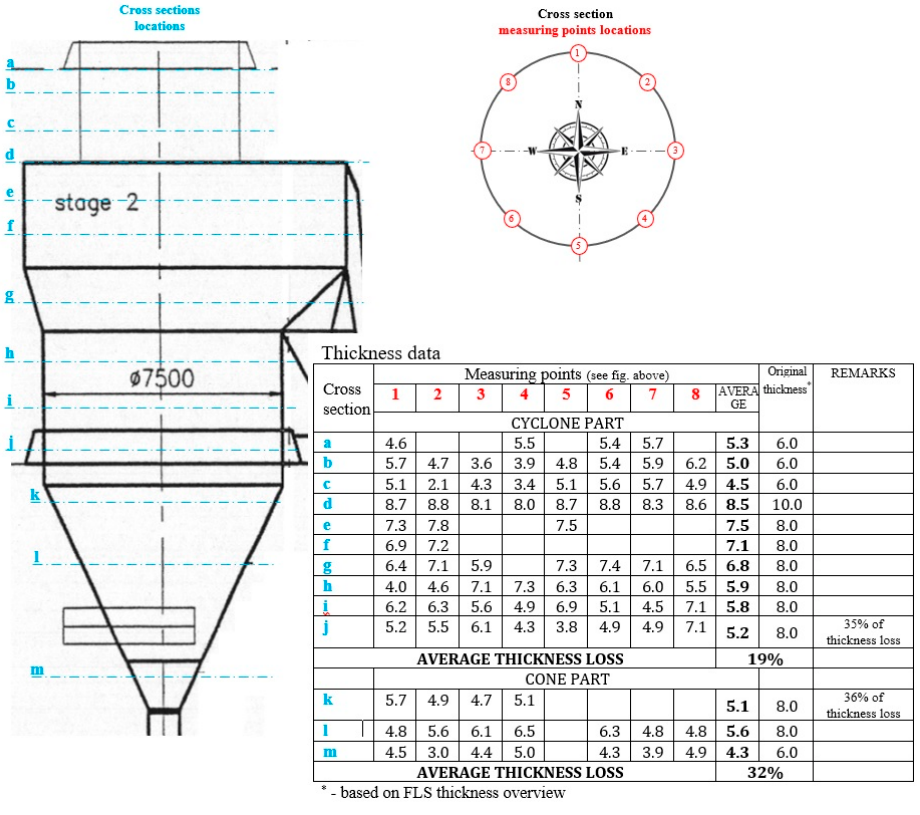
Figure 8. Thickness measurements results of one of the segments.